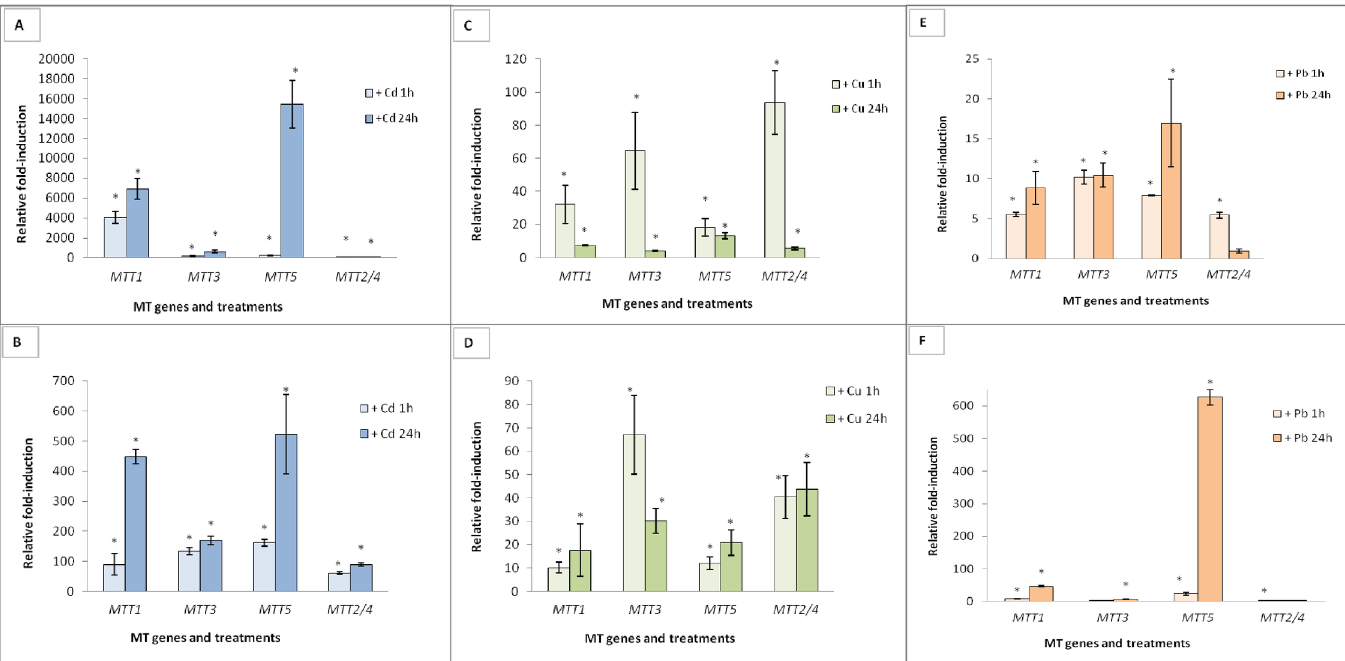
Fig 6. Relative fold-induction of the five T . thermophila MT genes in metal-adapted strains. These strains were maintained for 1 or 6 months without the metal treatment and then re-exposed(1 or 24h) to the relevant MTC. (A): Cd-adapafter 1 month without metal (-1M). (B): Cd-adapafter 6 months without metal (-6M). (C): Cu-adap(-1M). (D): Cu-adap(-6M). (E): Pb-adap(-1M). (F): Pb-adap(-6M). β -actinwas used as the normalizer gene. Each histogrambar representsan averagevalue ± standarddeviation(see S3 Table) from two or three independent experiments. Asterisks indicate significantdifferences from the control with p (cid:20)